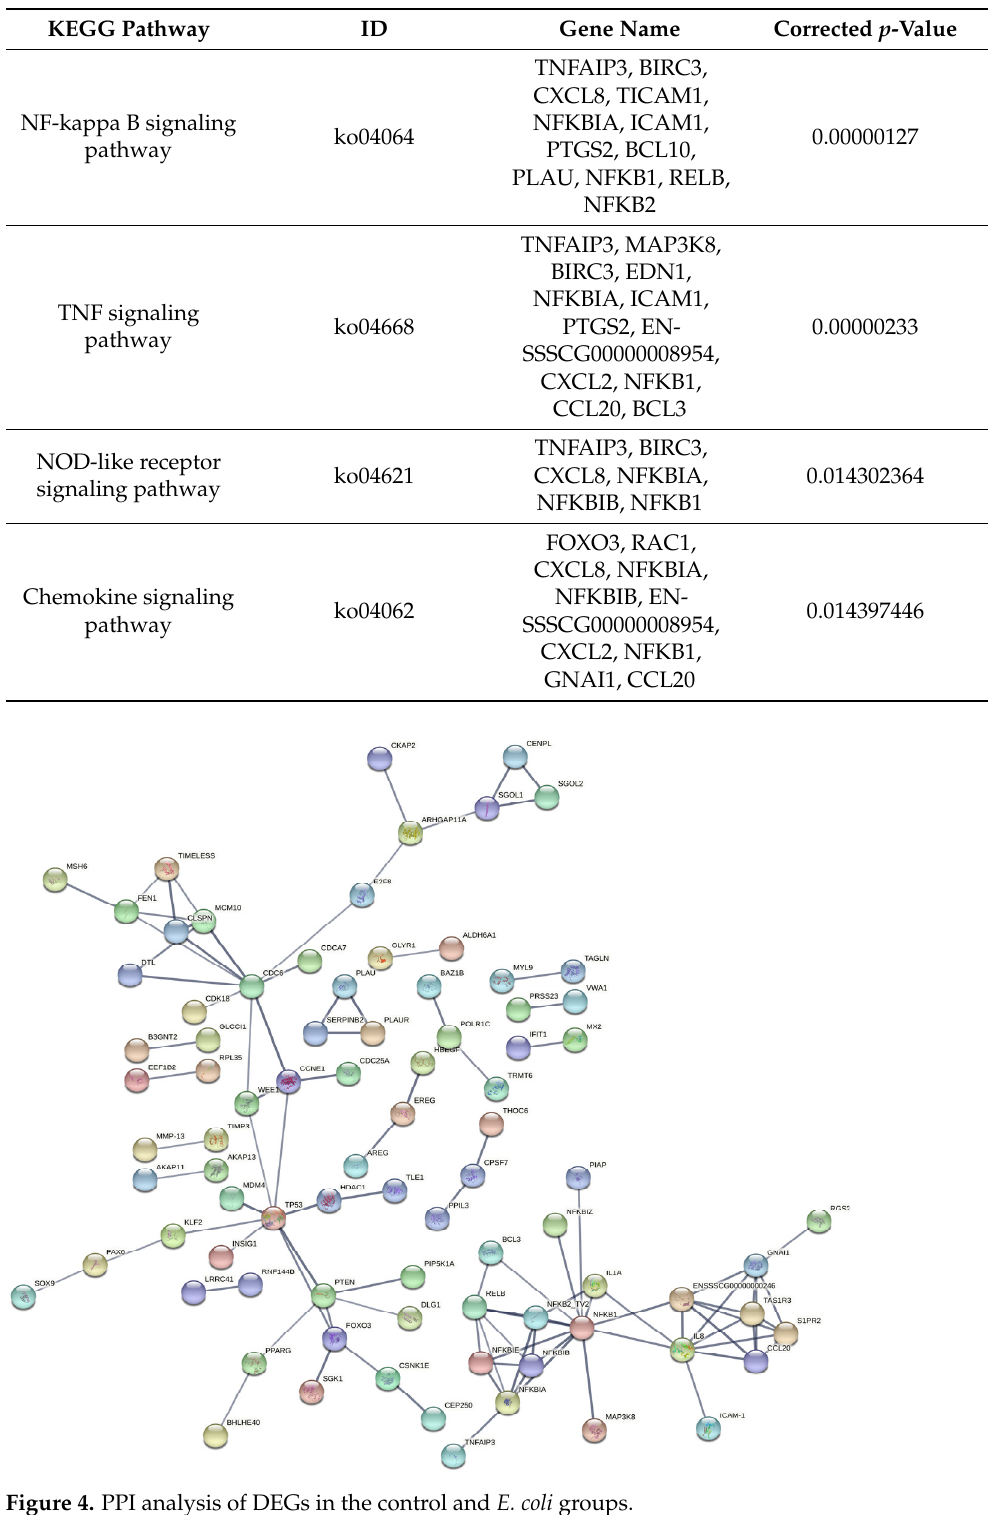
Table 3. DEGs involved in the immune signaling pathways caused by E. coli .